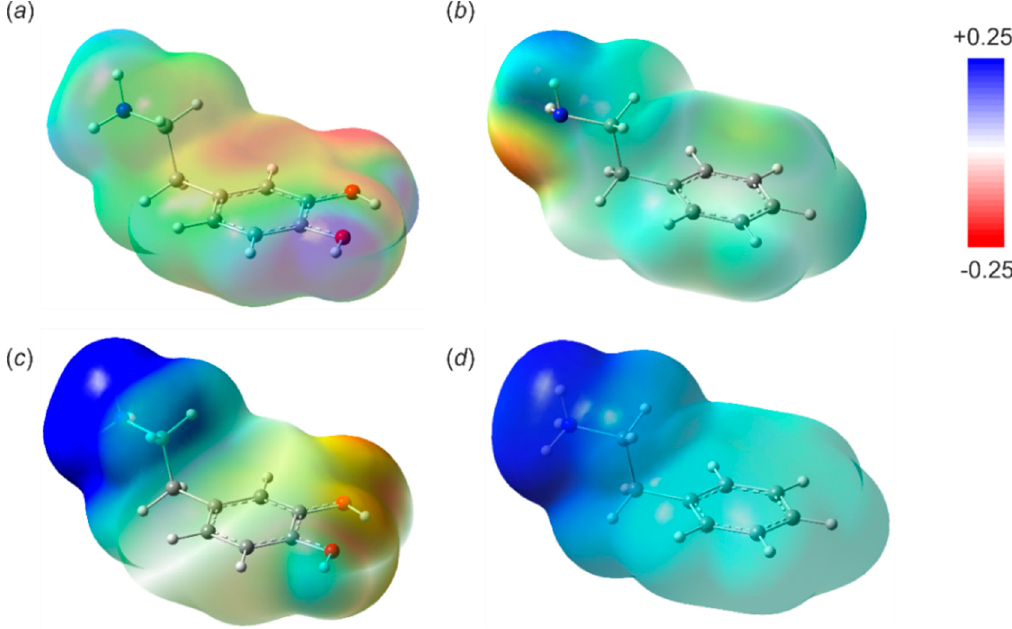
Figure 4. Semi-transparent representation of electrostatic potential (eÅ − 1 ) mapped onto the electron density surface ( ρ = 0.003 eÅ − 3 ) generated for: ( a ) dopamine, ( b ) phenylethylamine and their corresponding cationic forms ( c , d ).